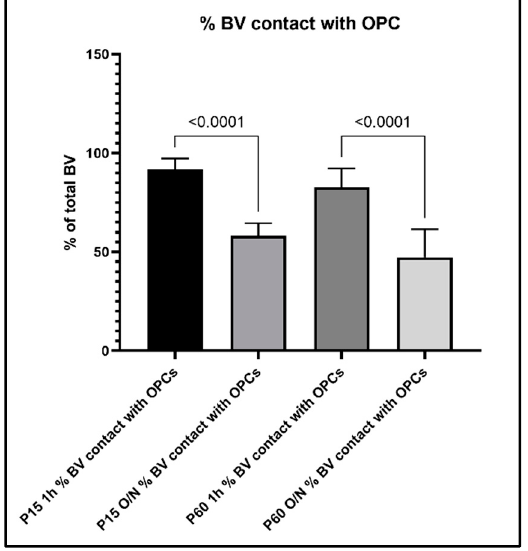
Figure 8. Percentage of blood vessel segments that were detected to have contacts with OPCs and their protrusions.